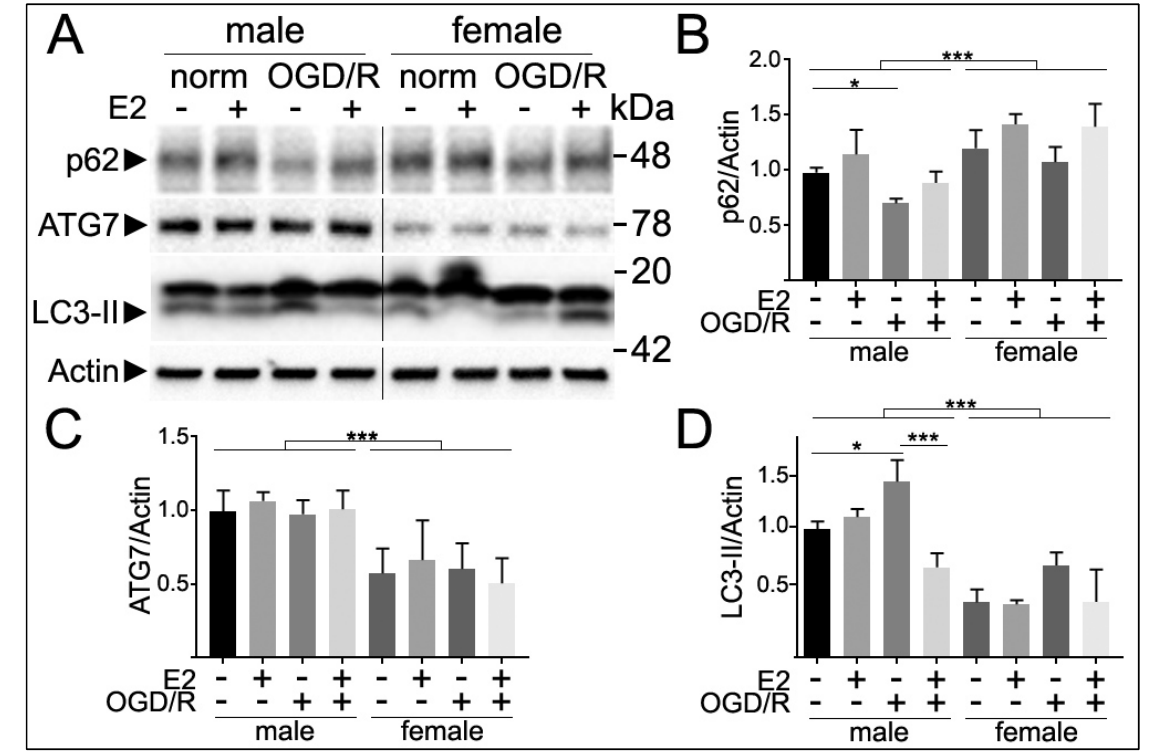
Figure 4. Sex differences in autophagy markers. ( A ) Cultured primary neurons from male and female embryonic rat pups (14 DIV) were pre-treated with 17β-estradiol (E2) or a vehicle (ethanol) for 1 h and then subjected to oxygen and glucose deprivation (OGD) or normoxia (norm) for 1 h. Complete media was restored (reperfusion, /R) for 6 h after treatments and cells were collected and processed for analyses of p62 and Atg7 levels by immunoblotting. ( B ) Quantification of p62 showed enhanced levels by sex ( p < 0.0001) without any interaction ( p = 0.399). Neurons from females exhibited enhanced levels of p62 compared with male neurons. OGD/R reduced levels of p62 compared with normoxia (norm) conditions in males but not in females. ( C ) Quantification of ATG7 showed reduced levels in female neurons compared with male neurons ( p = 0.0003) independently of treatments ( p = 0.606). No interaction was observed ( p = 0.962). ( D ) Quantification of the LC3-II band intensities showed enhanced levels by sex ( p < 0.0001) and treatments ( p < 0.0001) with interaction ( p = 0.014). Neurons from females exhibited reduced LC3-II levels. Post-hoc Tukey analyses were performed after two-way ANOVA analyses. * p < 0.05, *** p < 0.0001. Results were pooled from 4-5 male and 4-5 female embryonic (E20) pups.